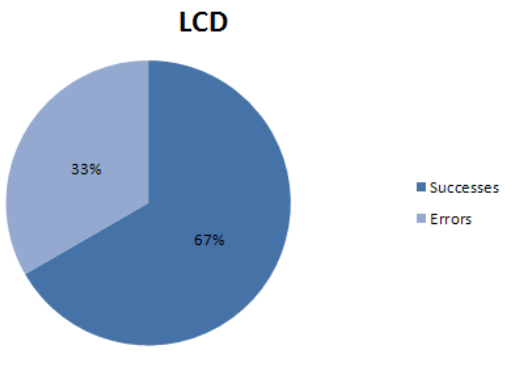
Fig. 18. Success rate in the third test when the user uses a LCD monitor.